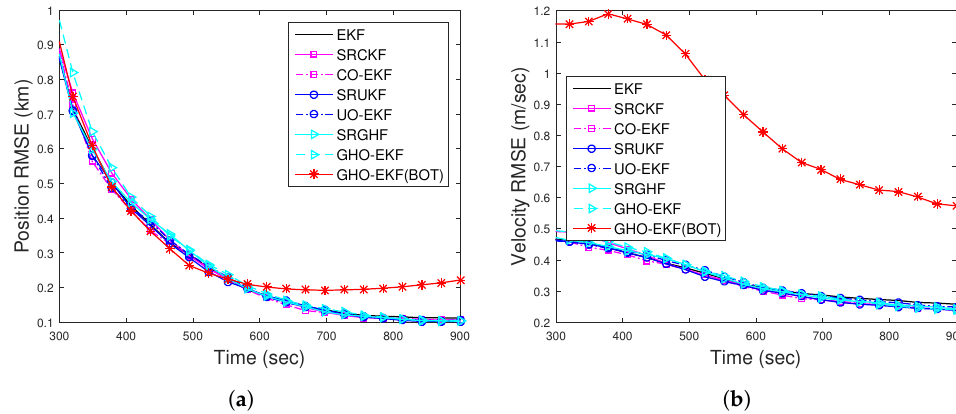
Figure 12. RMSEs of the ( a ) position; ( b ) velocity of the DBT for Scenario II.